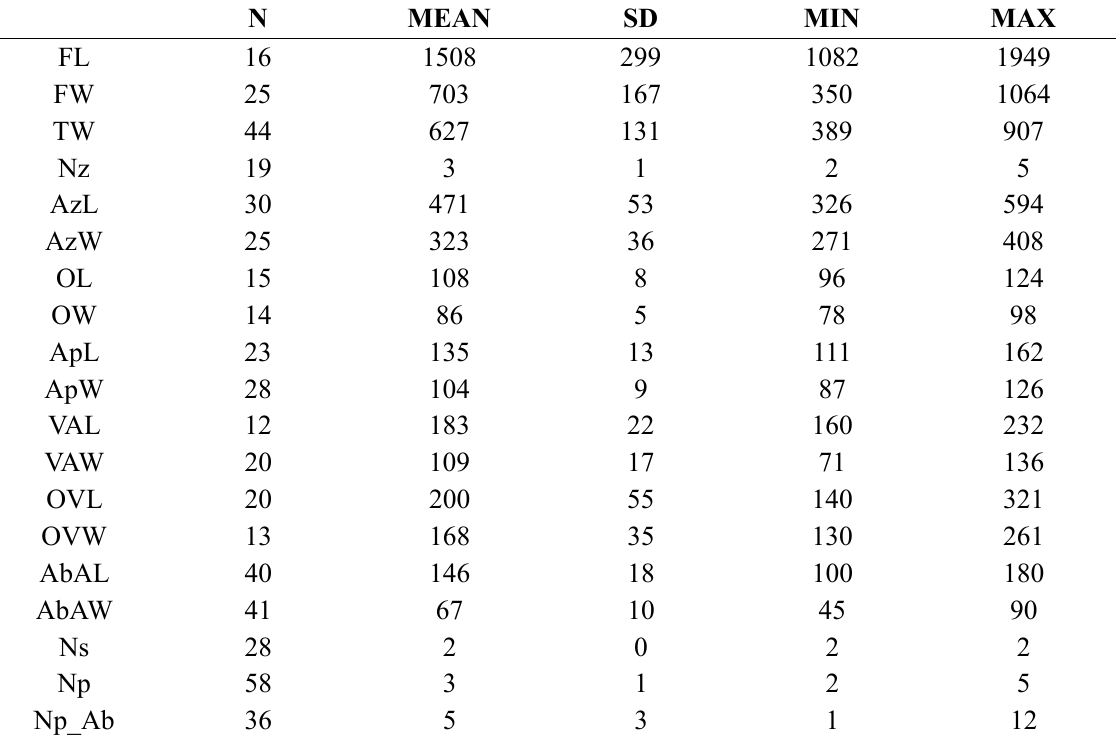
Table 4. Measurements of Schizoretepora imperati (Busk,